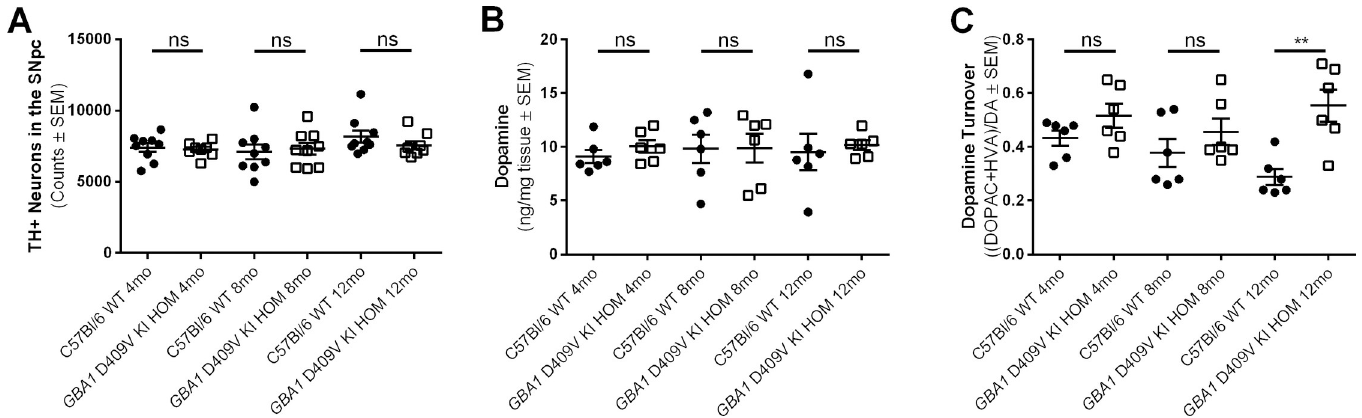
Fig 6. Dopamine turnover, but not total dopamine levels or nigral dopamine neuron numbers, are altered in aged homozygous GBA1 D409V KI mice as compared to controls. (A) Stereological estimates of dopaminergic neurons in the substantia nigra pars compacta (SNpc) as denoted by tyrosine hydroxylase immunoreactivity (TH +) reveal no differences between the GBA1 D409V KI homozygous (HOM) mice and C57Bl/6 wild type (WT) mice at any age (n = 9/group). (B) Dopamine levels as assessed by UHPLC/MS/MS in striatal tissue are unaltered in HOM GBA1 D409V KI mice at all ages (n = 6/group). (C) Dopamine turnover is significantly increased in 12 month old HOM GBA1 D409V KI mice as compared to WT controls (n = 6/group). TH neurons (A) measured as follows: WT 4mo 7402 ± 306.7, HOM 4mo 7263 ± 181.9, WT 8mo 7102 ± 503.5, HOM 8mo 7319 ± 412.9, WT 12 mo 8169 ± 429.1, HOM 12mo 7566 ± 294.9. Dopamine levels (B) measured as follows: WT 4mo 9.13 ± 0.62, HOM